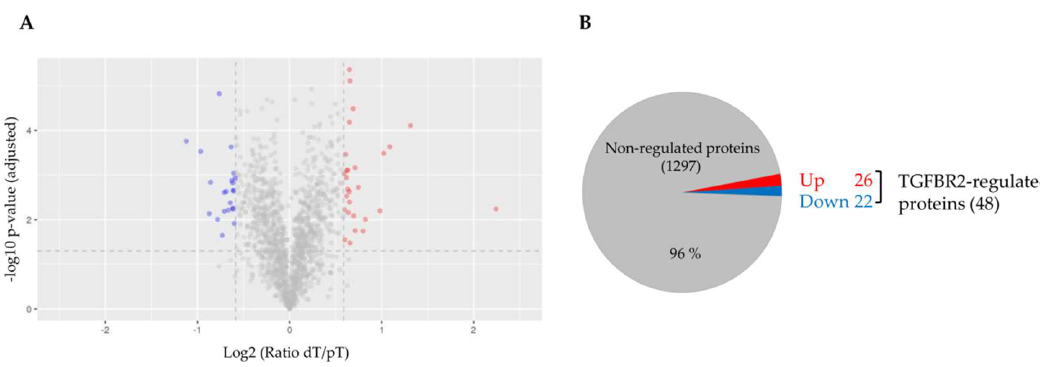
Figure 4. Analysis of TGFBR2-regulated proteins in EVs. ( A ) Volcano plot shows non-regulated proteins ( grey ) and significantly up- ( red ) and downregulated ( blue ) proteins of EVs derived from TGFBR2-deficient cells. X axis represents log 2 -transformed fold change values. Y axis shows the −log 10 p -value adjusted for multiple comparisons; ( B ) Pie chart specifies non-regulated EV proteins ( grey ) and EV proteins up- ( red ) and downregulated ( blue ) by cellular TGFBR2 deficiency.